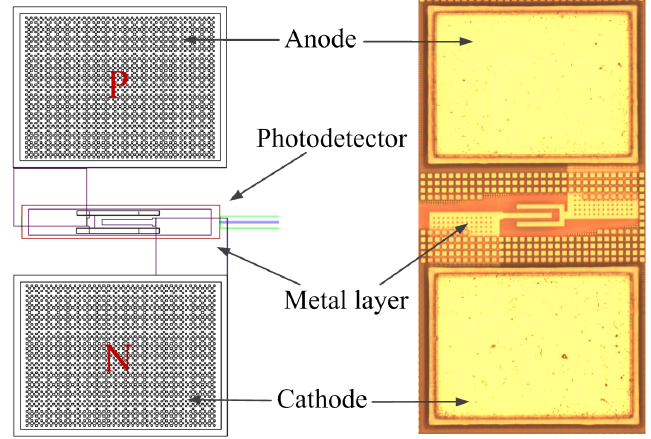
Figure 5. Layout of the photodetector (PD) and micrograph of the